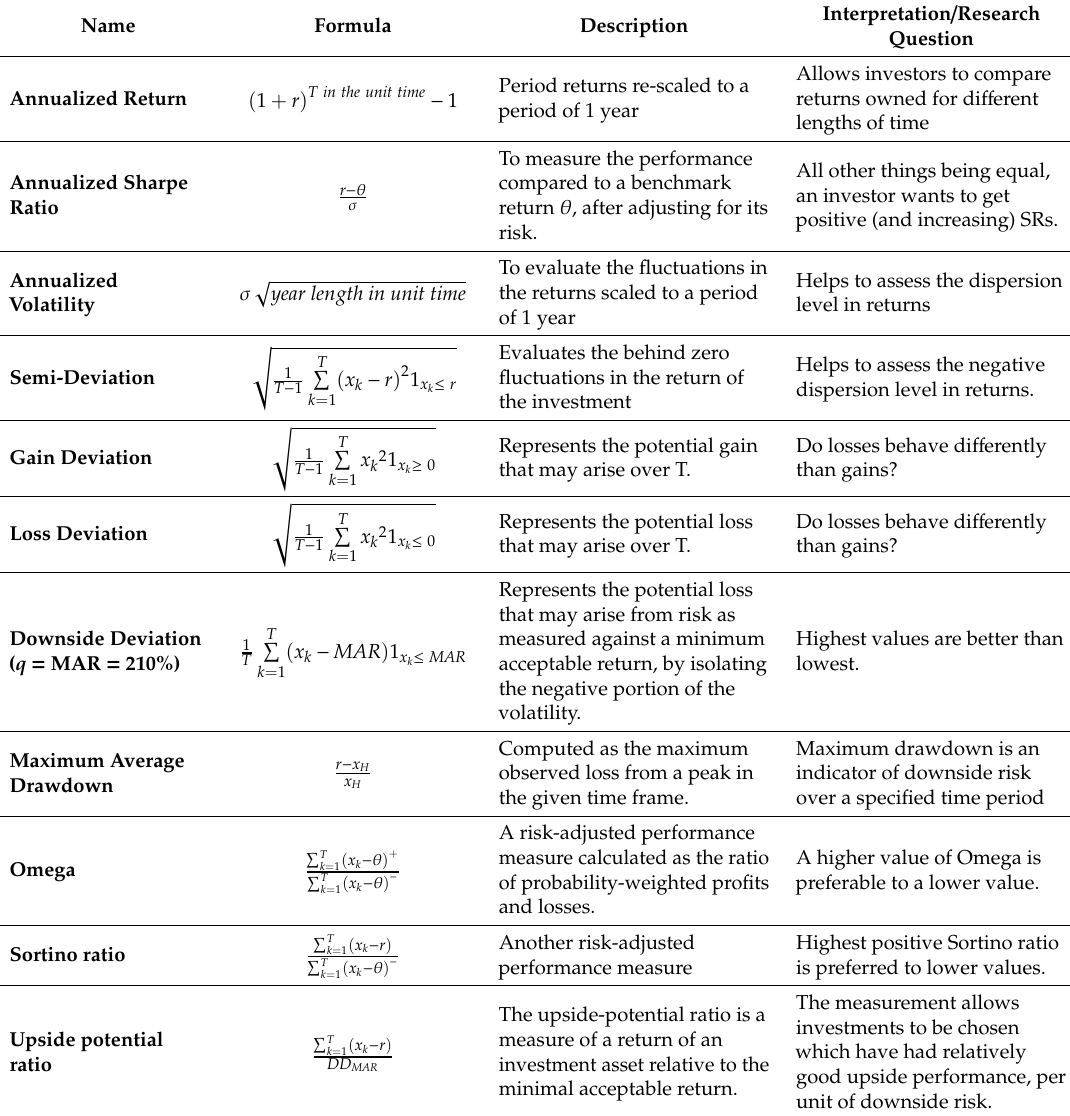
Table 3. Performance metrics and related